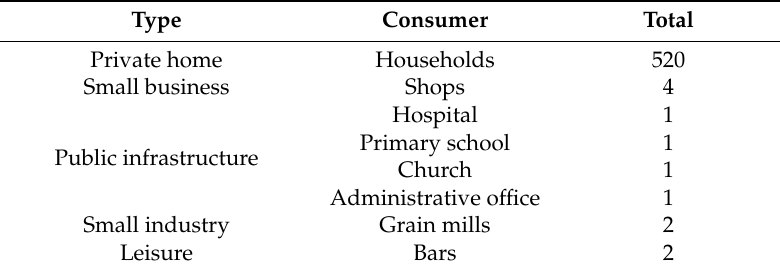
Table 2. Potential consumers of electricity in Chua Village.